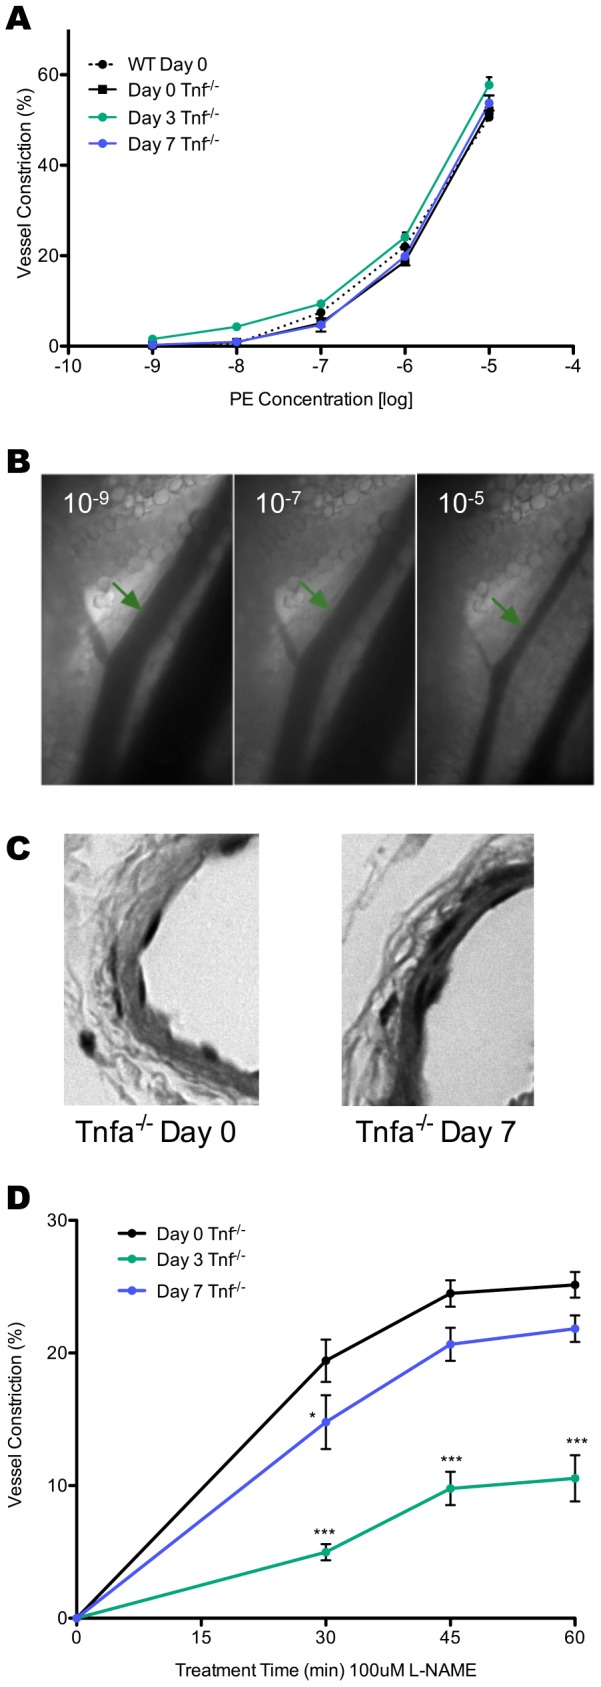
Phenylephrine (PE) dose response (percent vessel constriction) from 10−9M to 10−5M at zero (n = 5), three (n = 4), and seven (n = 4) days p.i. in TNFα-/- mice in comparison to WT C57 BL/6 mice (n = 5) (A).Representative images of lymph node arterioles following at day zero p.i. prior to PE application and following superfusion of 10−9, 10−7, and 10−5M PE (B). In each image the arteriole is shown to the upper right of the LN venule and indicated by a green arrow (C). Representative images of H&E stained arteriole cross-sections in TNFα-/- mice zero and seven days p.i. Percentage of vessel constriction in TNFα-/- mice in response to perfusion of 100μM L-NAME at days zero (n = 5), three (n = 4), and seven (n = 4) following infection (D). Data represents mean vessel constriction (A, C) ± SEM where one arteriole was studied per animal. *p<0.05, **p<0.01, and ***p<0.001.